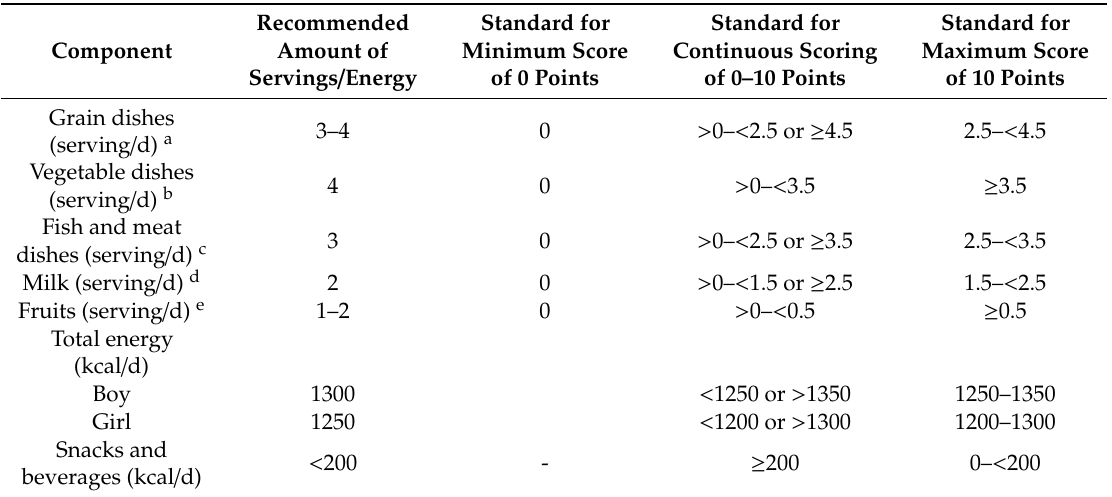
Table 1. Components of the Japanese Food Guide Spinning Top score in preschool children